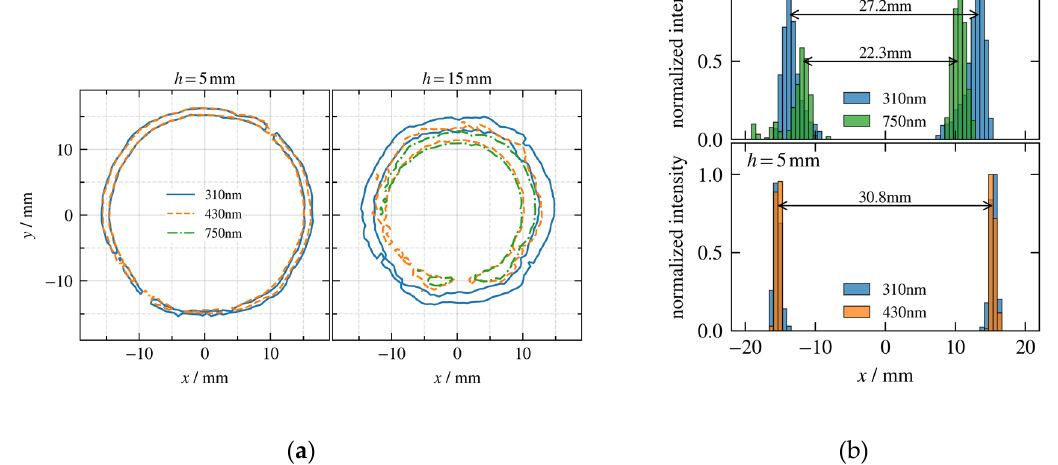
Figure 11. ( a ) Iso-lines of horizontal cross-sections at h = 5, and h = 15 mm. ( b ) 1D radial profiles Figure 11. (a) Iso-lines of horizontal cross-sections at h = 5, and h = 15 mm. (b) 1D radial profiles through the center of the horizontal through the center of the horizontal slices.